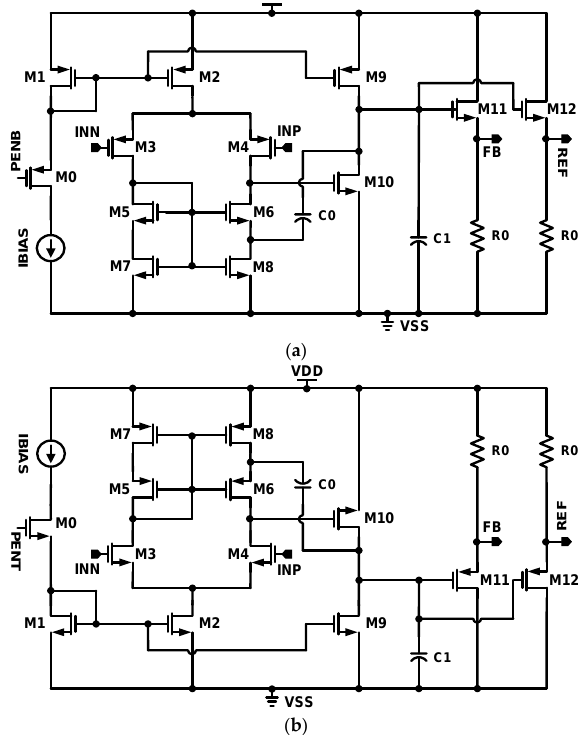
Figure 8. Source-follower type reference voltage buffer: (a) P-type, (b) N-type.